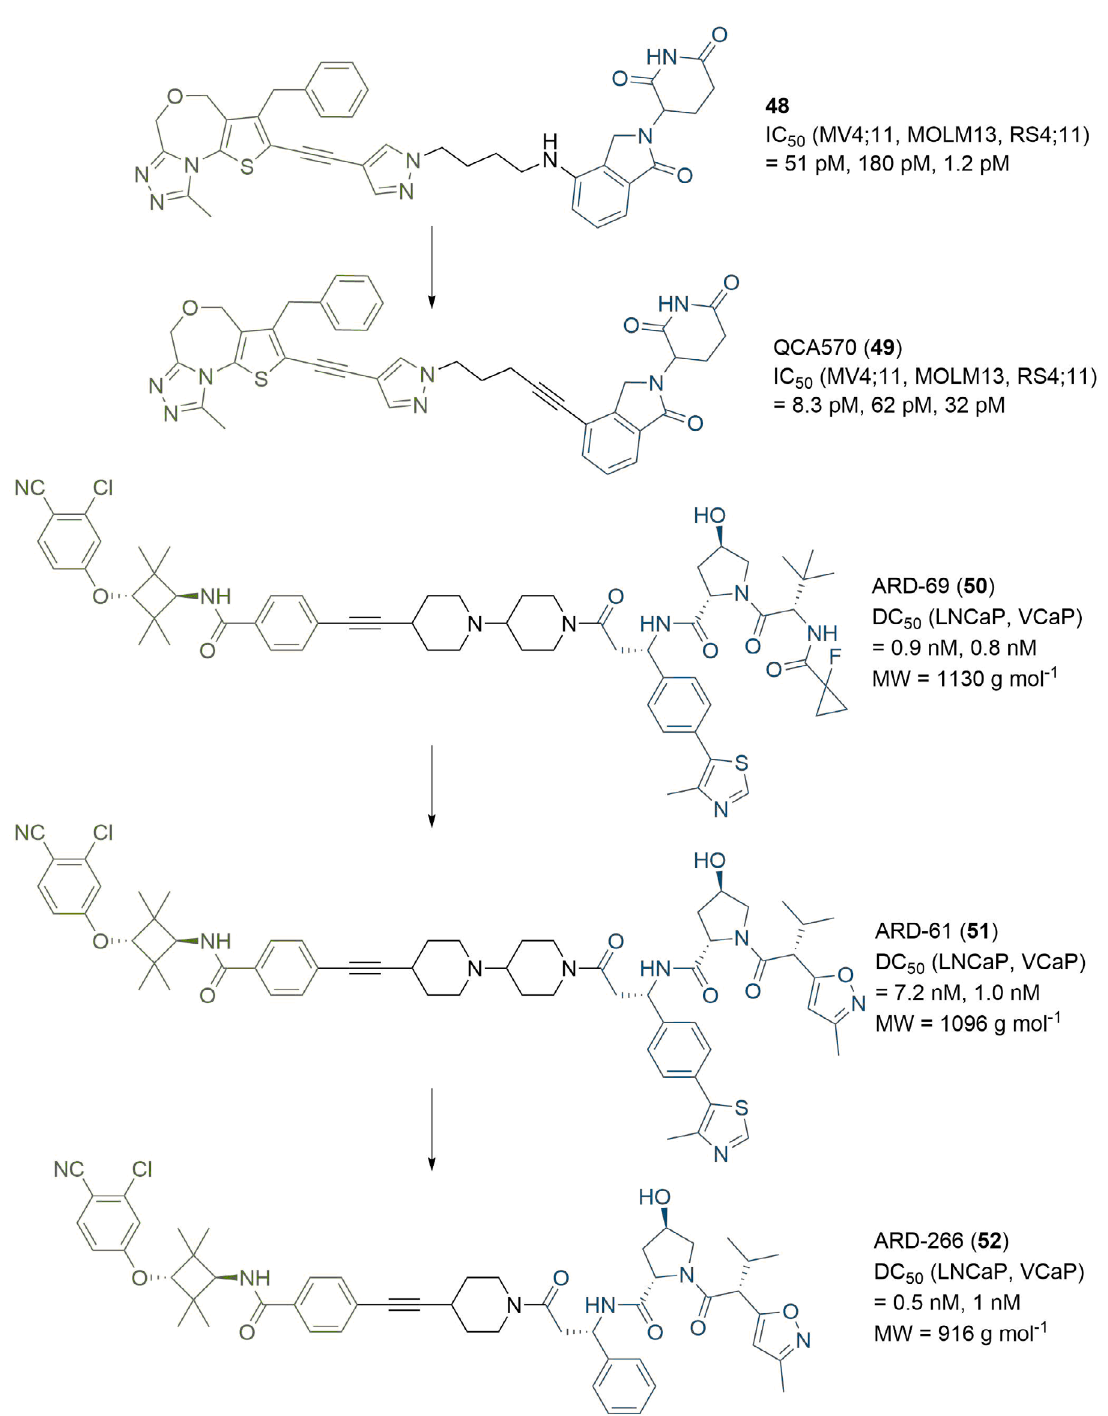
Figure 9. PROTACs with rigid linkers. Replacement of the amine connecting group to thalidomide in 48 with a rigid alkyne led to 49, which exhibited enhanced cell growth inhibition in 2/3 tested cell lines. Modifications to the anchor of 50 afforded 51, and further changes to the linker and anchor provided 52, which retained high degradation potency with a > 200 reduction in MW vs.